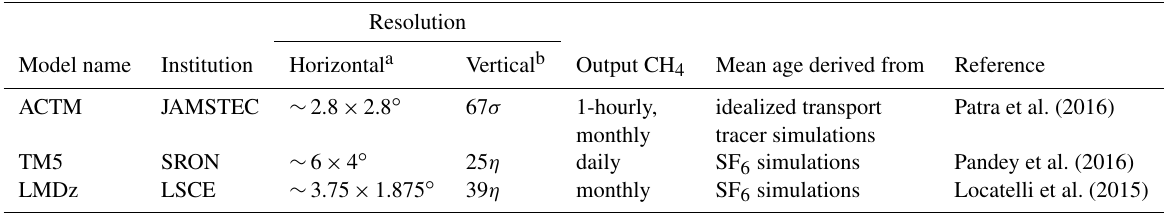
Table 1. Overview of CTMs used for model–TCCON